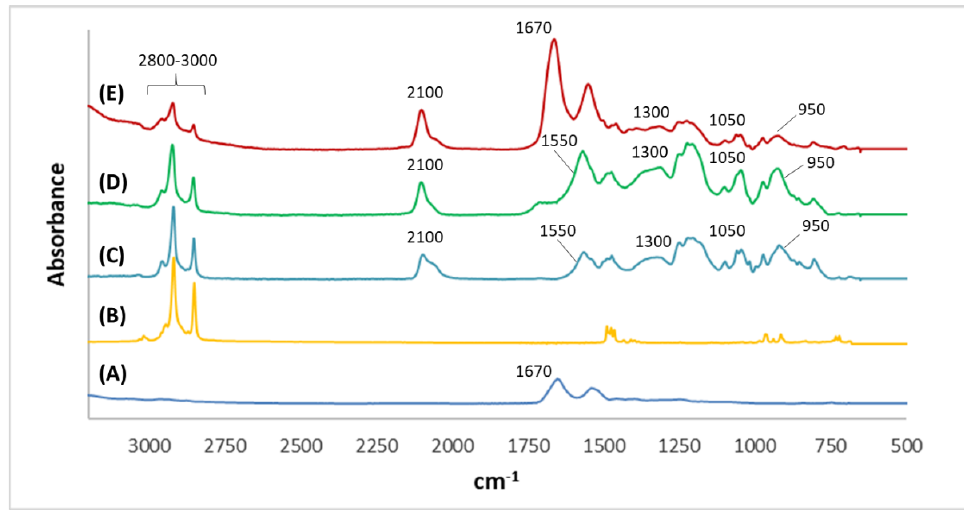
Figure 3. Infrared spectra in the 3200–500 cm − 1 range of ( A ) LYS, ( B ) HTMA, ( C ) NIPPy/GO@Fe 3 O 4 , ( D ) MIPPy/GO@Fe 3 O 4 , and ( E ) MIPPy/GO@Fe 3 O 4 incubated in